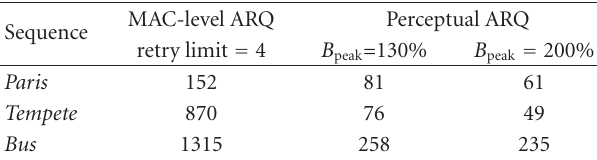
Figure 12: Used bandwidth as a function of the peak bandwidth for the proposed ARQ scheme, compared to the Soft ARQ technique and to the value corresponding to the best PSNR performance of the MAC-level and CBRL ARQ schemes ( paris sequence). Transmission through the relay node.